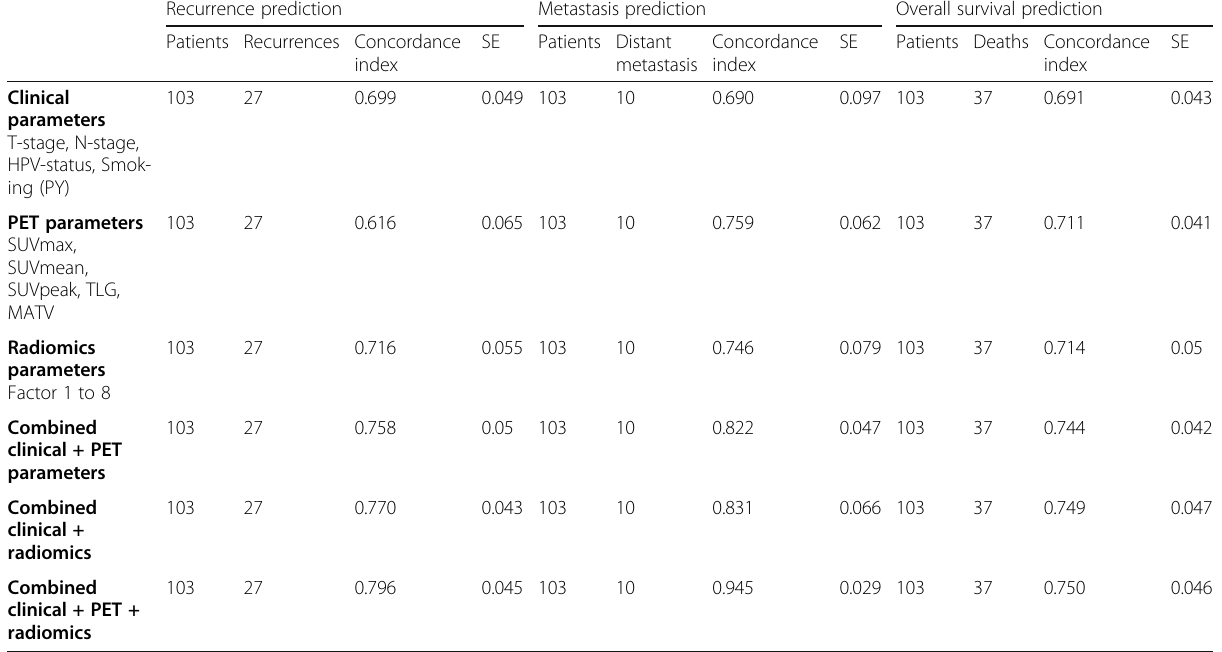
Table 3 Predictive accuracy of clinical parameters, PET-parameters, and radiomics factors separately and combined for the prediction of locoregional recurrence, metastasis, and death